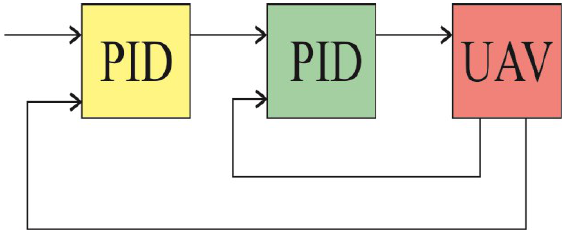
Fig. 10. Schematic diagram of the control system The controller input is an offset between the angle setpoint value from the pilot and the measured